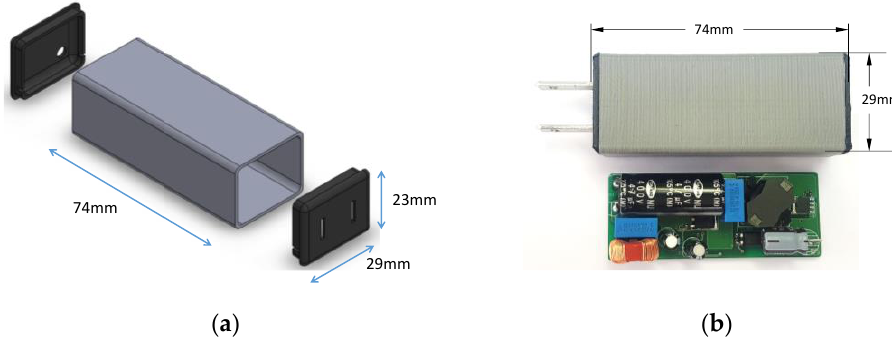
Figure 18. External shape and size of AC – DC adapter using QR flyback converter with SDAS: ( a ) external shape and size of AC – DC adapter; ( b ) internal PCB and case of AC – DC adapter for experimentation.